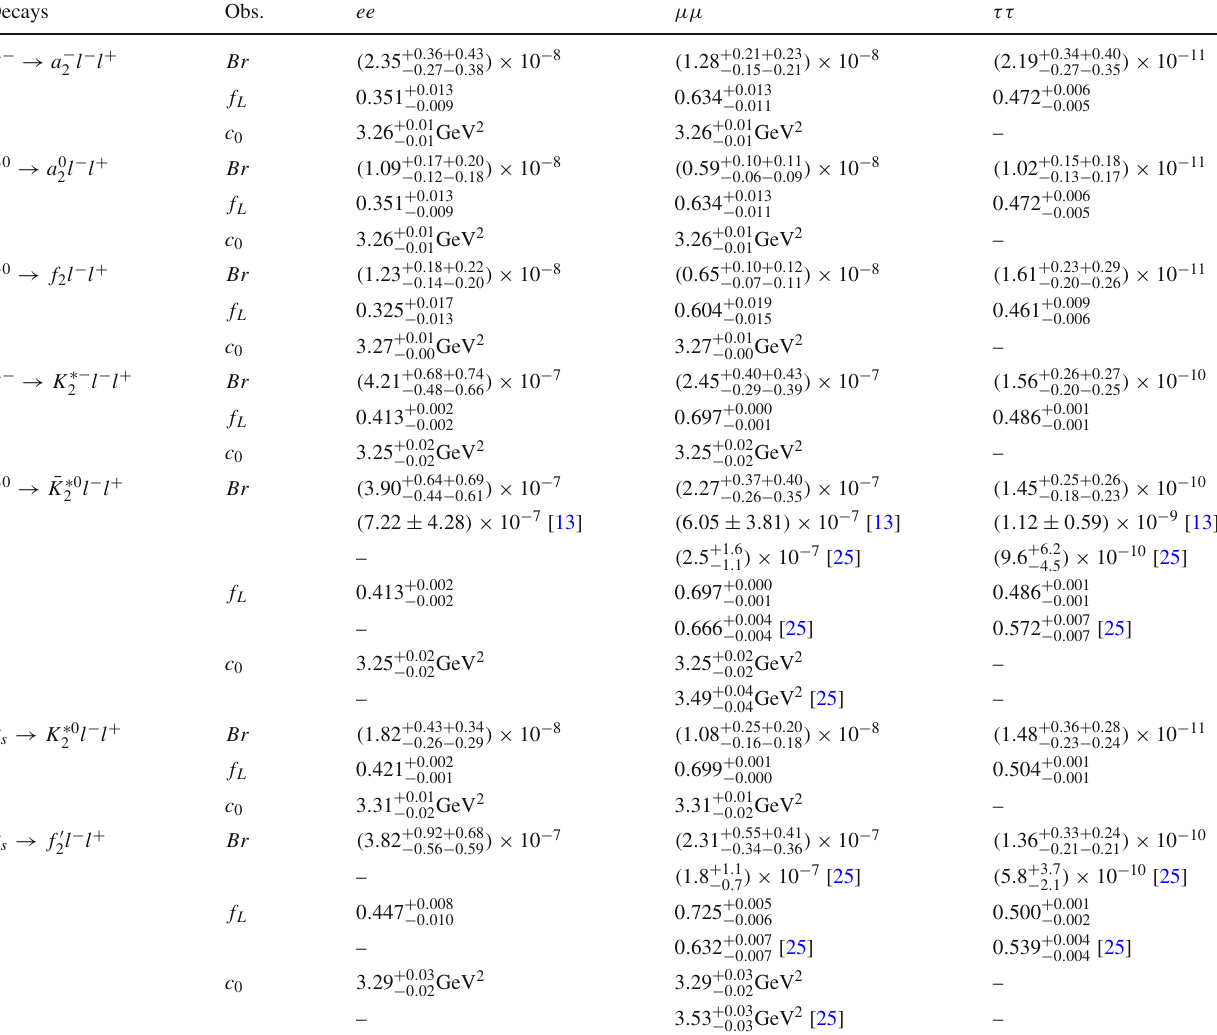
Table 7 The Br , f L and c 0 for rare B ( s ) → Tl − l + decays, where the values calculated by LCSRB [13] and pQCD [25] are also listed for comparison